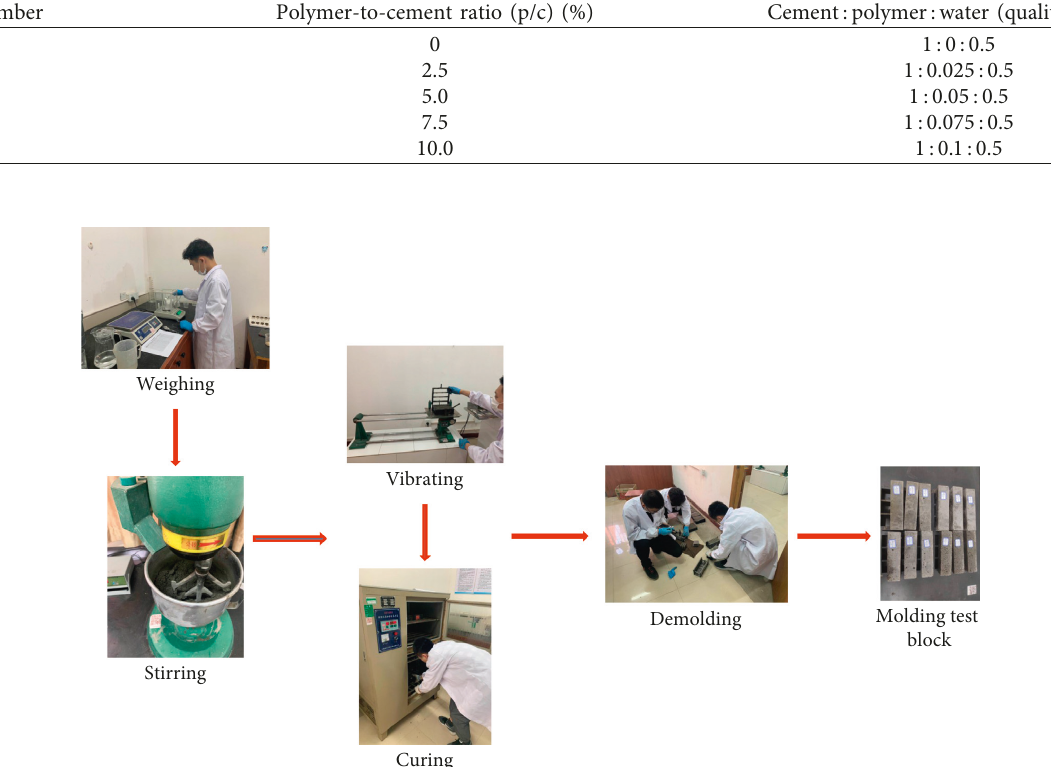
Figure 4: Mixing and curing of the modified styrene-acrylic emulsion cement